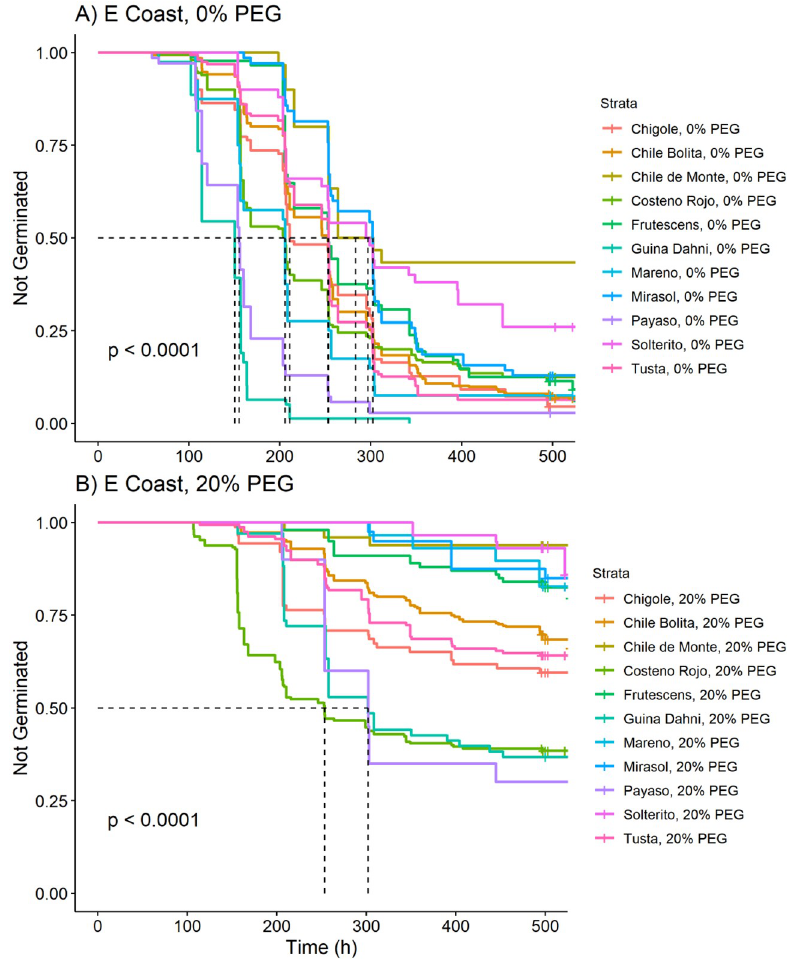
Fig 5. Kaplan-Meier estimates of survivor functions for chile pepper accessions originating from the Eastern Coast of Oaxaca, Mexico. (A) Eastern Coast, PEG = 0%; (B) Eastern Coast, PEG = 20%. The p-value from a log-rank test compares survival distributions. The dotted line represents the time to 50% germination (t 50 ). Pairwise comparisons of individual curves are presented in Table 9 in S3